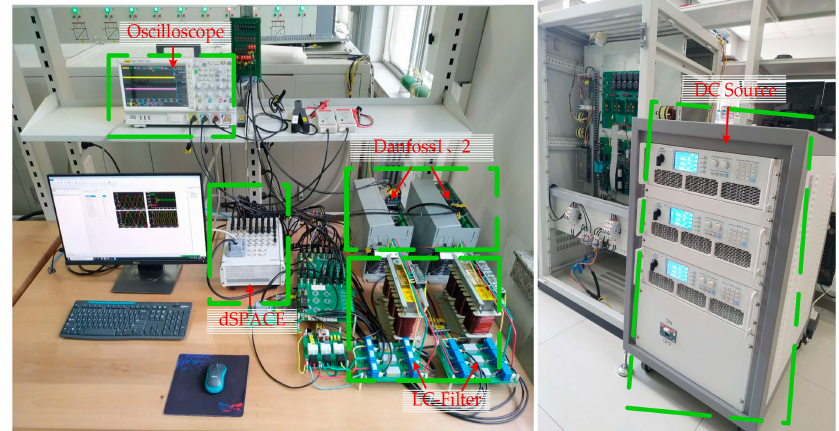
Figure 8. Experimental platform for the parallel operation of two